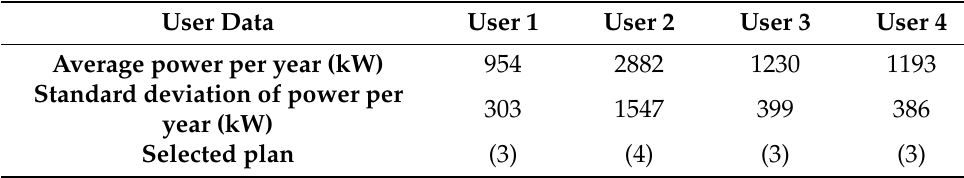
Table 2. Average and standard deviation power per year and the selected plan of each user.